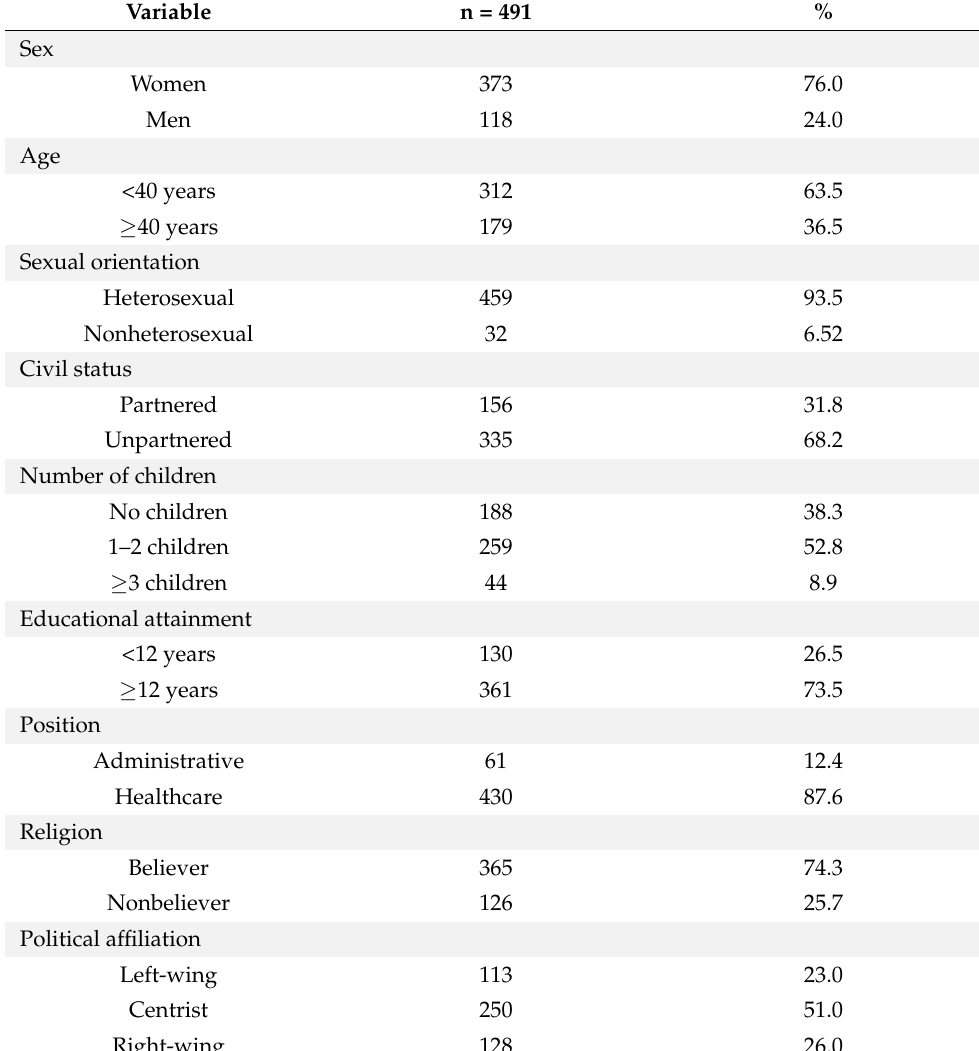
Table 1. Sociodemographic characterization of study